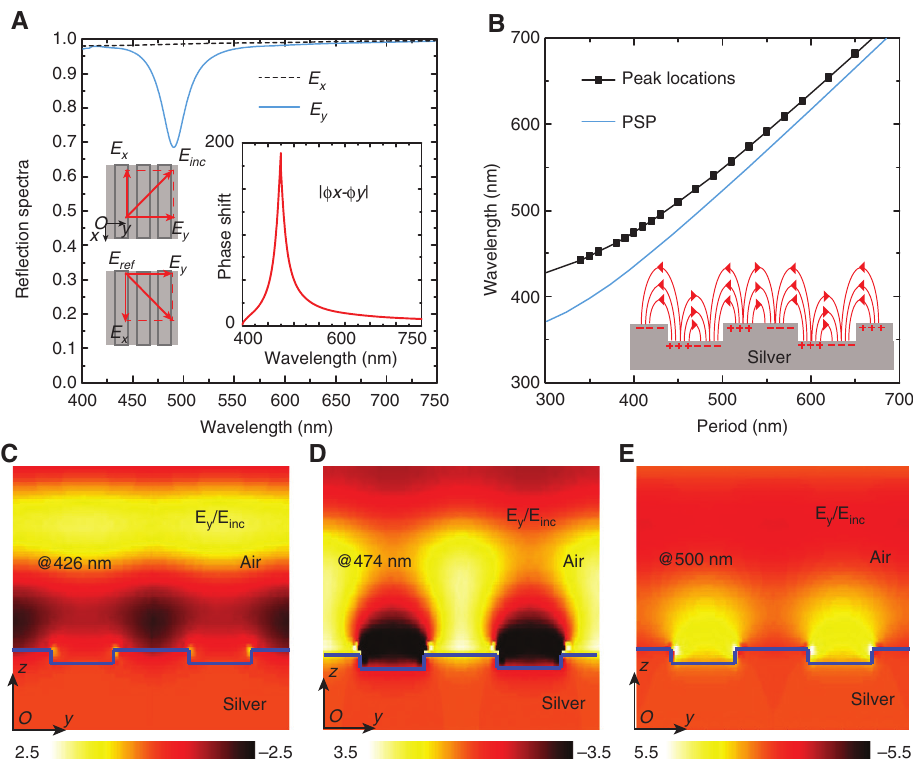
Figure 4: (A) Reflective spectral amplitudes for x - and y -polarized waves. The inset shows the calculated phase difference between the two orthogonal polarizations. (B) Comparison between the reflective peaks and PSP resonant wavelengths corresponding to variable grating periods. The inset depicts the collective oscillation of free electrons at the silver-air interface. (C–E) 2D color maps of the electric field ( E distribution with a period of 400 nm at (C) λ = 426 nm, (D) λ = 474 nm, and (E) λ = 500